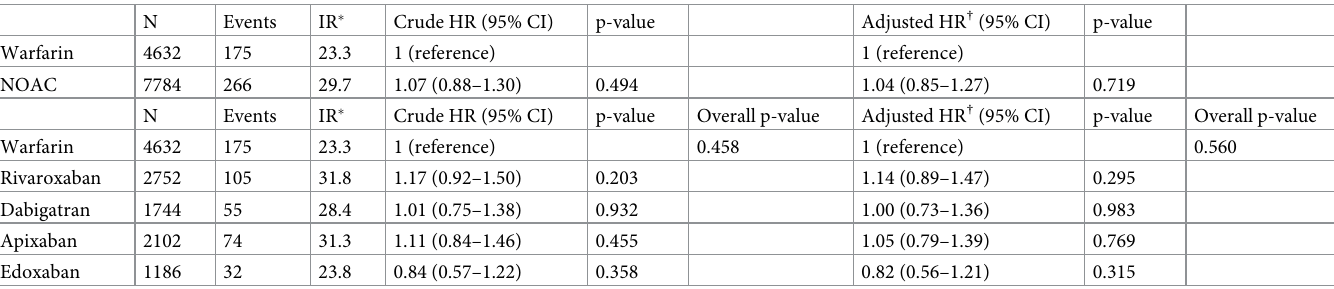
Discussion In a large cohort of patients on OAC and PPI co-therapy, significant differences were clinically observed in upper gastrointestinal bleeding risk according to the OACs used. Specifically, NOACs were associated with lower risk of upper gastrointestinal bleeding compared to warfarin, after multivariable adjustment for age, sex, baseline comorbidities, and concomitant medication including antiplatelet agents and NSAIDs. The largest reduction in upper gastroin- testinal bleeding risk was noted with apixaban and edoxaban, as compared to warfarin. Among four individual NOACs, the difference in upper gastrointestinal bleeding risk was not statistically significant. The trend of reduced risk for upper gastrointestinal bleeding in NOACs compared to warfarin was consistent for both regular and reduced dose NOAC regi- mens, and in subgroup analyses stratified by age, sex, indication for OAC use, number of Table 4. Risk of stroke according to OAC treatment in patients with atrial fibrillation.